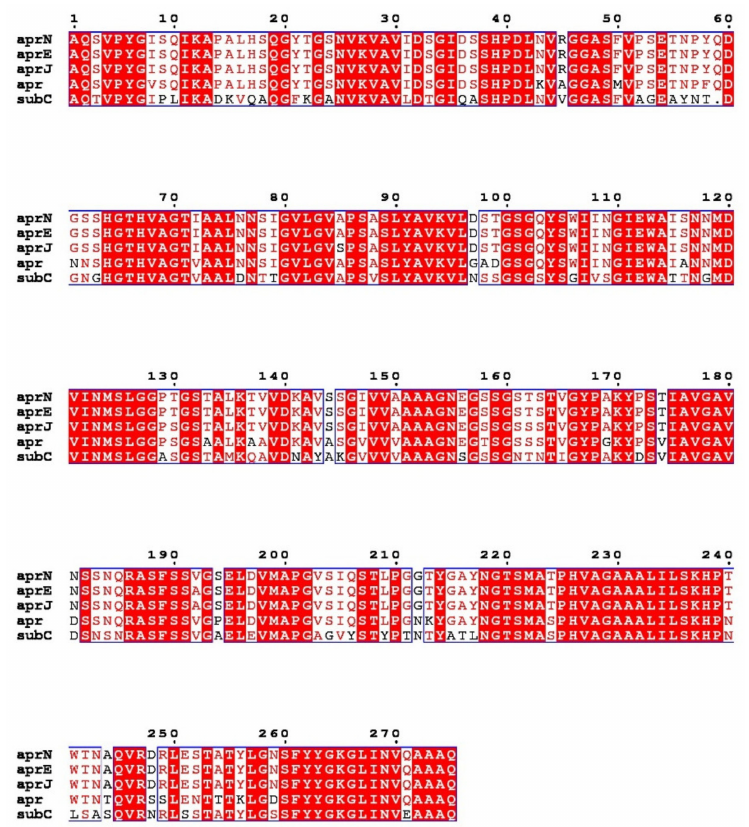
Figure 1. Multiple sequence alignment of nattokinase ( Apr N) compared with other serine pro- tease homologs. Red shading and red words represent identical and similar residues,